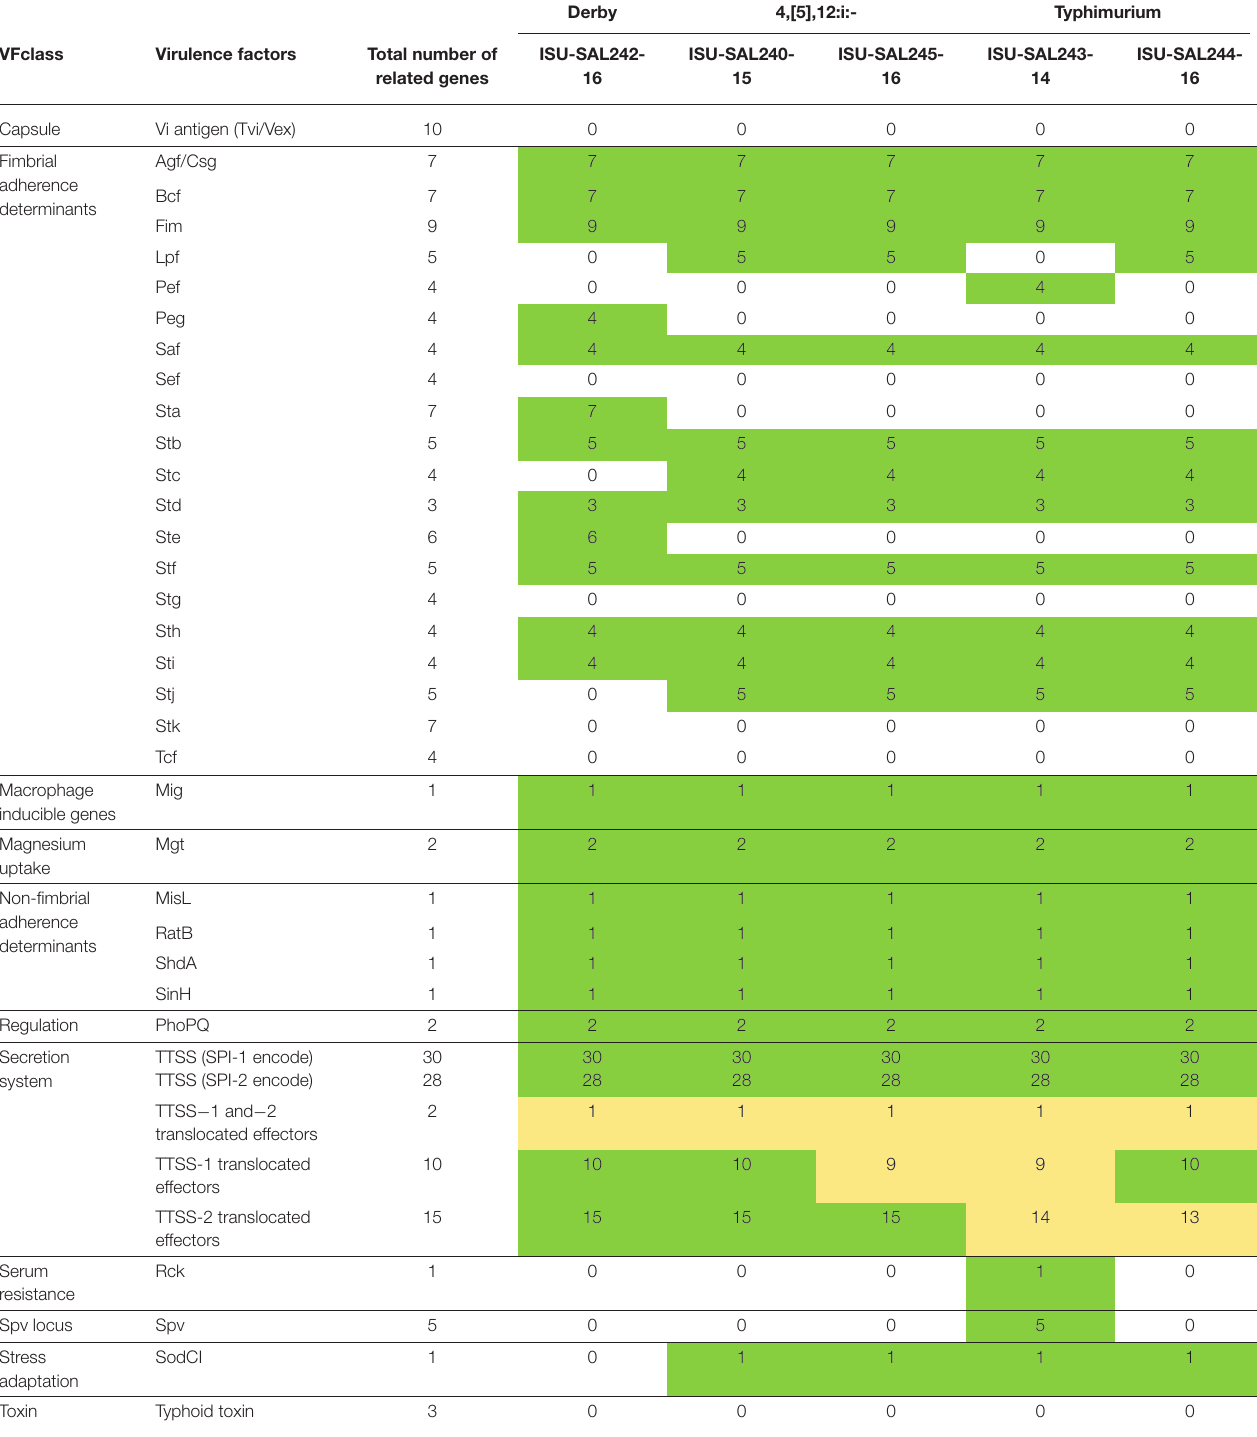
TABLE 4 | Results of Virulence Factor Database (VFDB) analysis for the presence of known virulence genes based on whole genome sequencing of isolates of Salmonella utilized for inoculation of pigs in animal studies #2 and